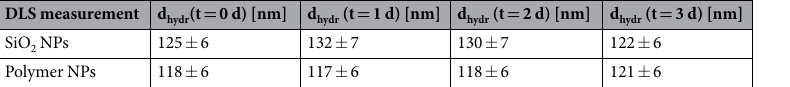
Table 1. Hydrodynamic diameters of the used nanoparticle formulations incubated in complete culture medium, measured via DLS in Lab 4 (Duisburg-Essen) for variable time periods. These results show that all NPs were indeed colloidally stable under the conditions and on the timescales of our experiments. Moreover, determination of hydrodynamic diameter of NPs immediately after transfer in complete culture medium was consistent among the laboratories (Supplementary Table